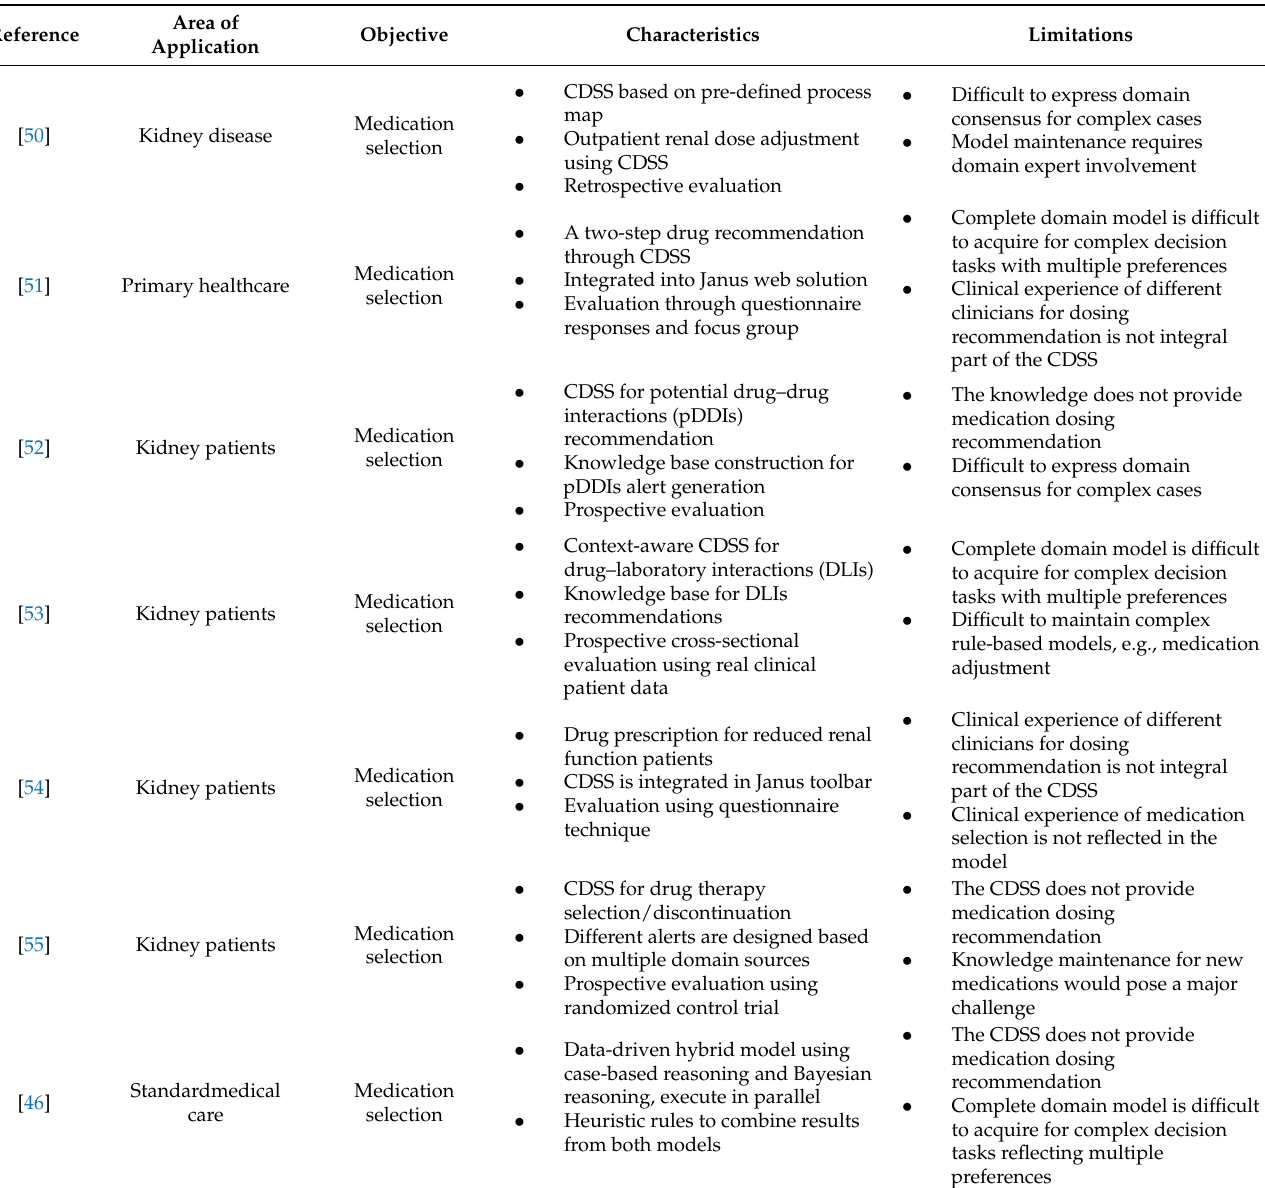
Table 3. Literature Comparison-Medication